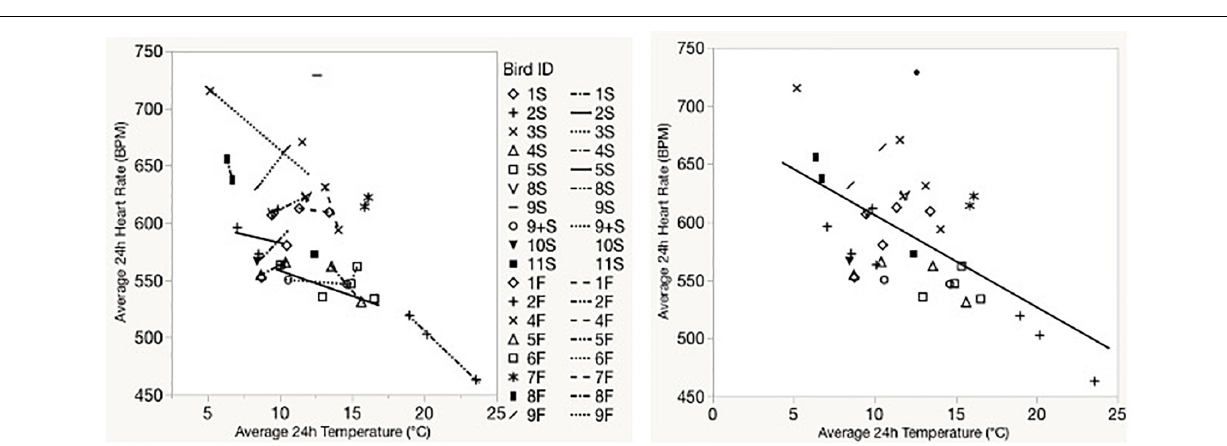
FIGURE 4 | Standard regression lines showing relationships between 24-h average heart rate and temperature for individual birds (left) and for all birds (right) in field telemetry experiments. “F” and “S” in bird ID numbers reflect data collected during fall and spring field seasons,